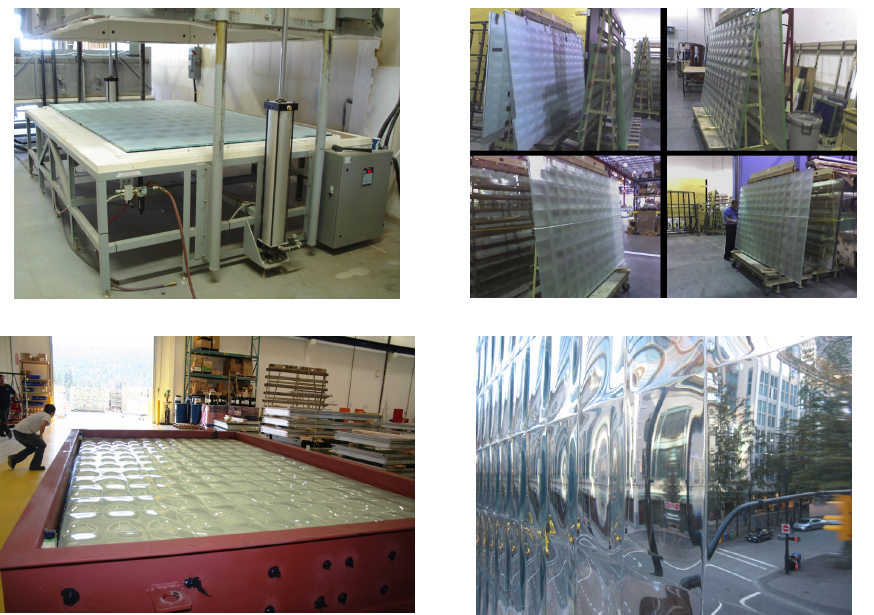
Figure 14 a, b, c, d: Slumping Oven, Production Panels, Thermal Test Rig, Detail View